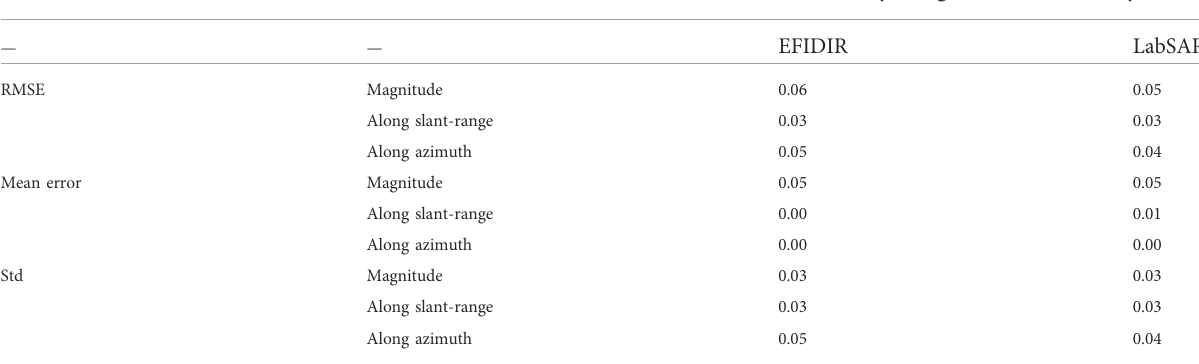
TABLE 3 Comparison of the RMSE, ME, and std of the velocity magnitude, slant-range velocity, and azimuth velocity computed over stable ground using the EFIDIR and LabSAR approaches. The results are in m/day.